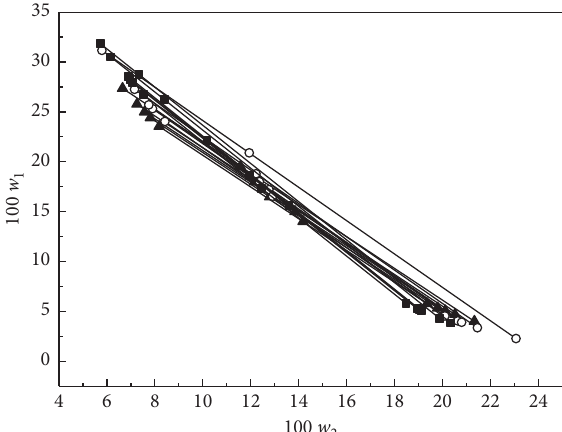
Figure 4: The tie-lines of the quaternary system polyethylene glycol+ ethanol+Na 2 SO 4 +water determined at T � 308.15, 318.15, and 328.15K; ▲ 308.15K; ○ 318.15K; ■ 328.15K.